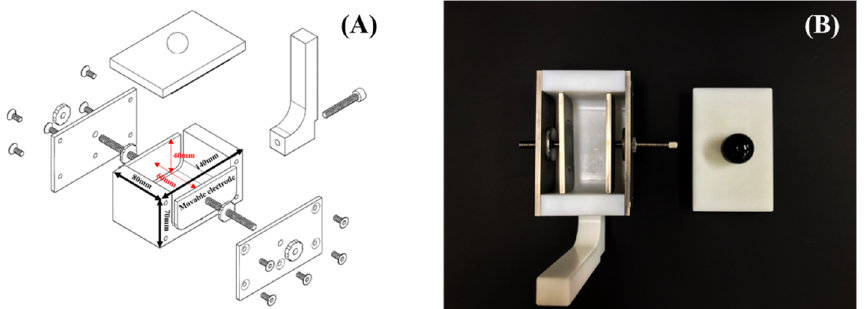
Figure 1. Models of the adjustable PEF batch chamber. ( A ) Three-dimensional assembly drawings, ( B ) final shape of the chamber. ( B ) final shape of the